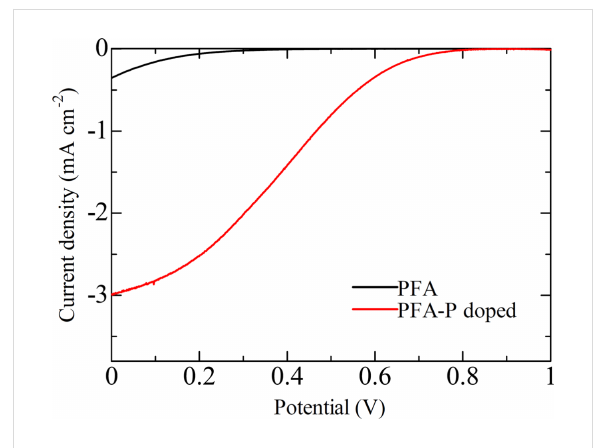
Figure 8: ORR voltammograms of two different PFA-derived carbon